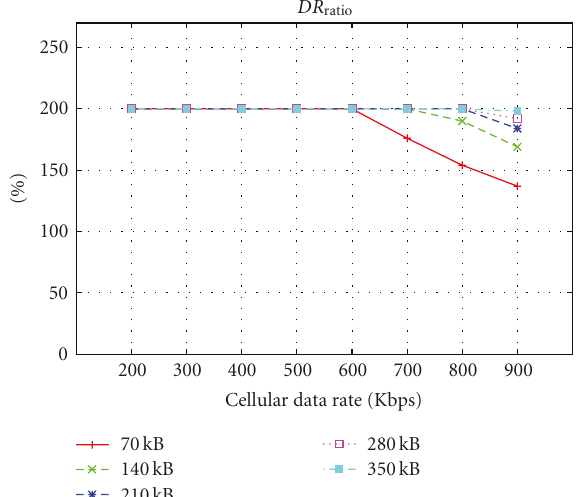
Table 1: Mean values for T BTsetup and DR BT .